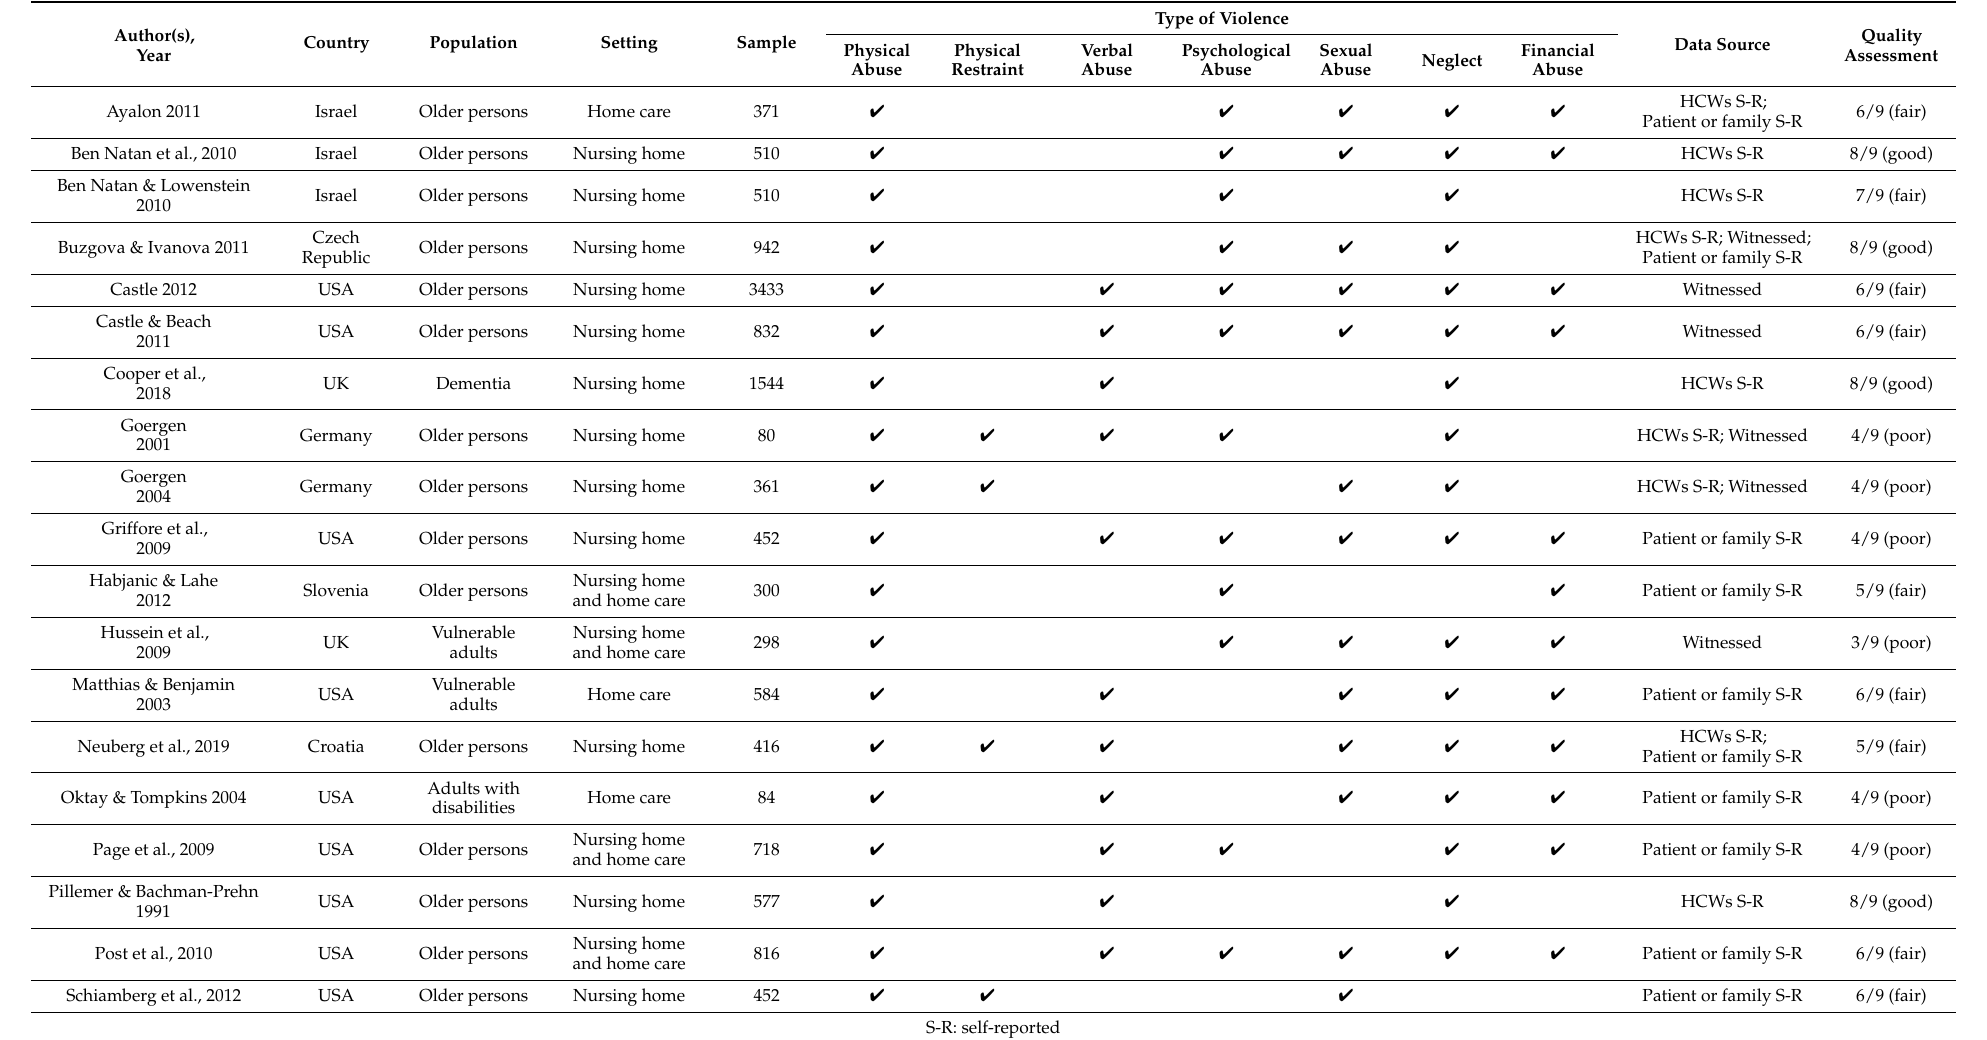
Table 1. Included studies’